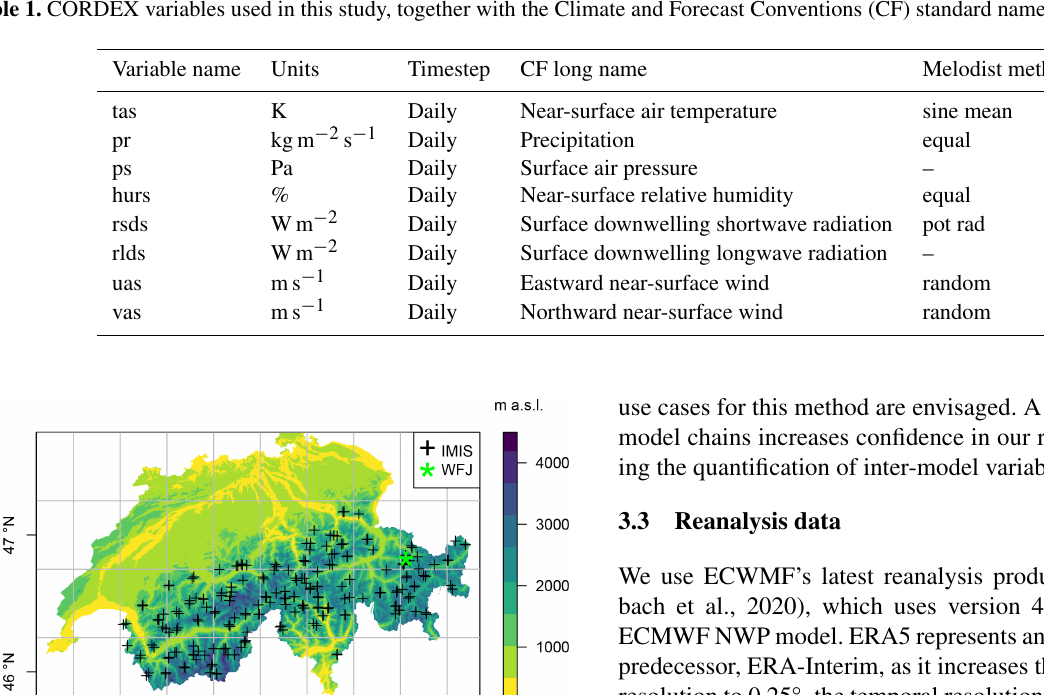
Table 1. CORDEX variables used in this study, together with the Climate and Forecast Conventions (CF) standard names.